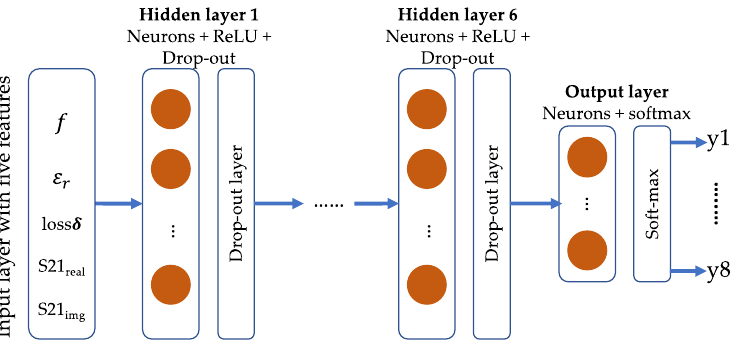
Figure 6. The overall DNN structure. The hidden layers comprise multiple fully connected, ReLU and Drop-out layers. The output layer comprises the fully connected layer followed by a soft-max.